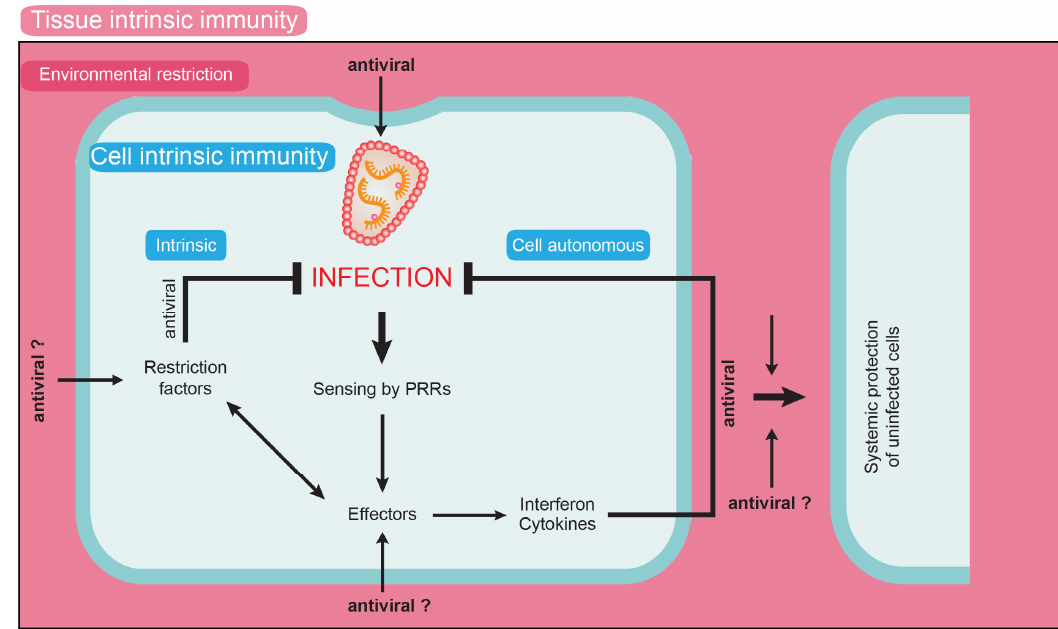
Figure 4. Schematic representation of the environmental restriction concept. Human cells bear cell-